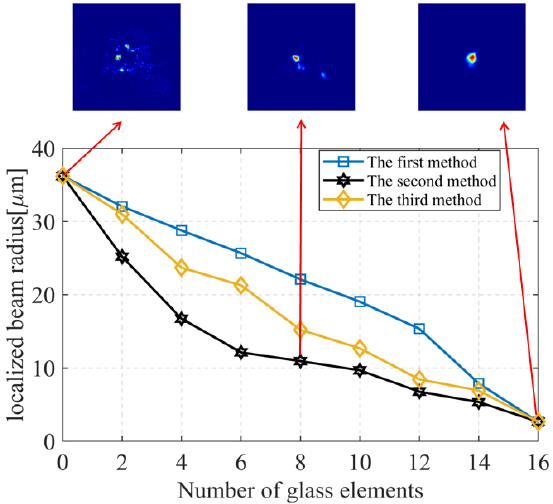
Figure 2. The relationship between the number of glass elements in the light incident region and the resulting localized beam radius.